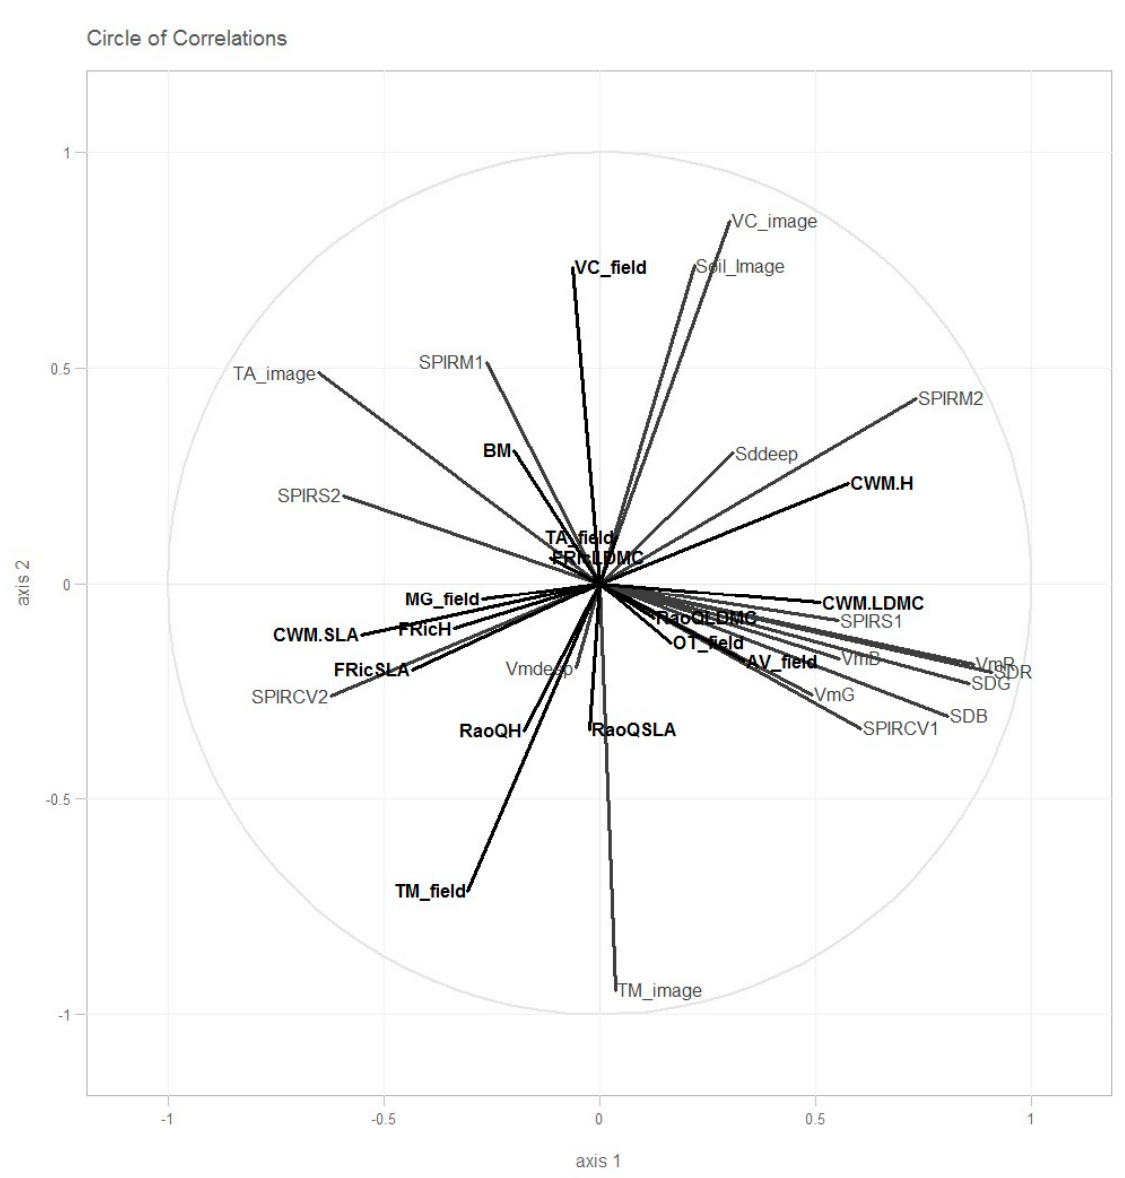
Figure 2. Correlation circle of PLS regression. The vegetation descriptors measured in the field are in black and the variables obtained from the plenoptic image and NIRS are in gray.